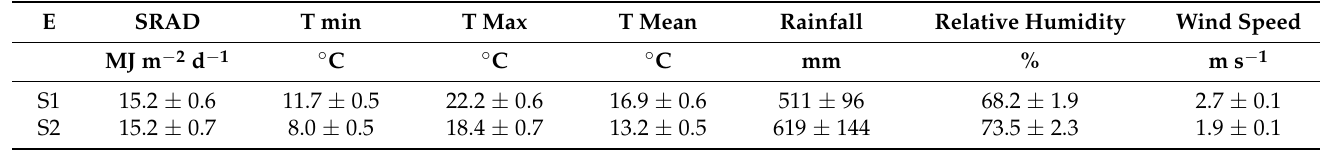
Abbreviations are as follows: E = environment; FC = field capacity (%m 3 water/m 3 soil); WP = wilting point (%m 3 water/m 3 soil); AW = available water (%m 3 water/m 3 soil); BD = bulk density; EC = elec-